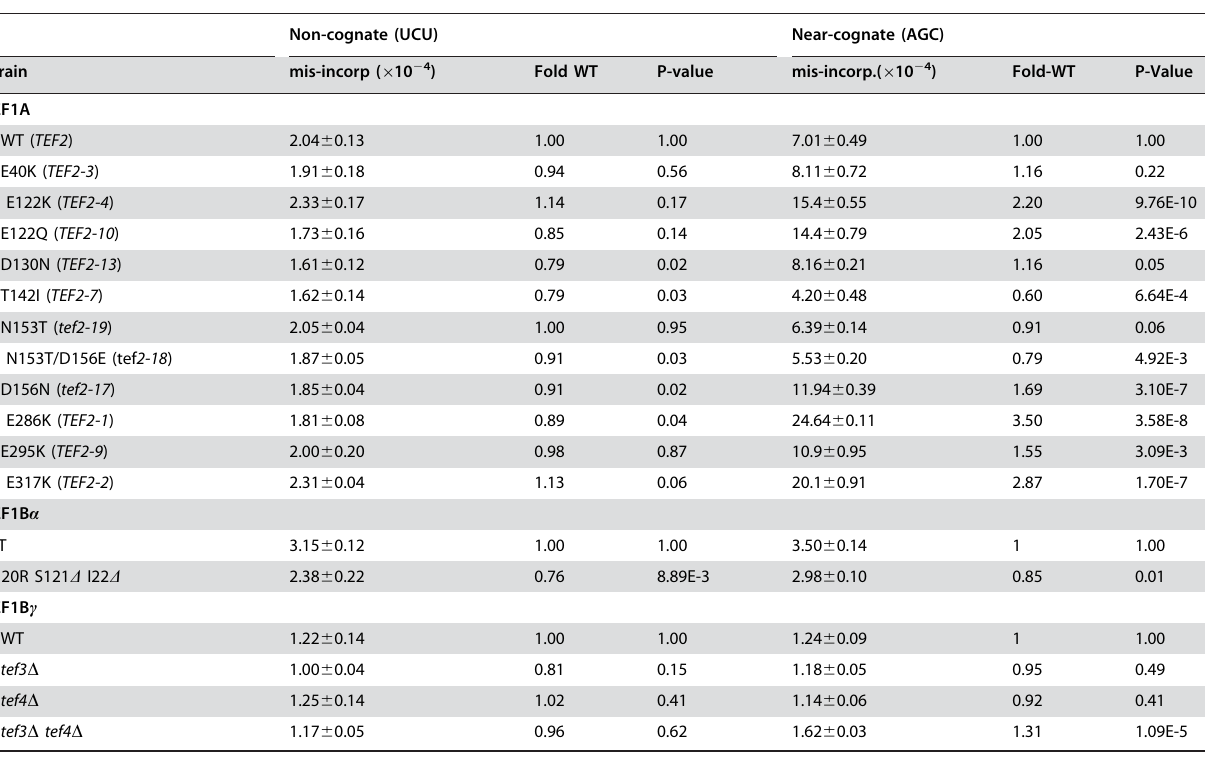
Table 2. Effects of selected alleles of genes on mis-reading of non-cognate and near-cognate mutations at codon 218 of firefly